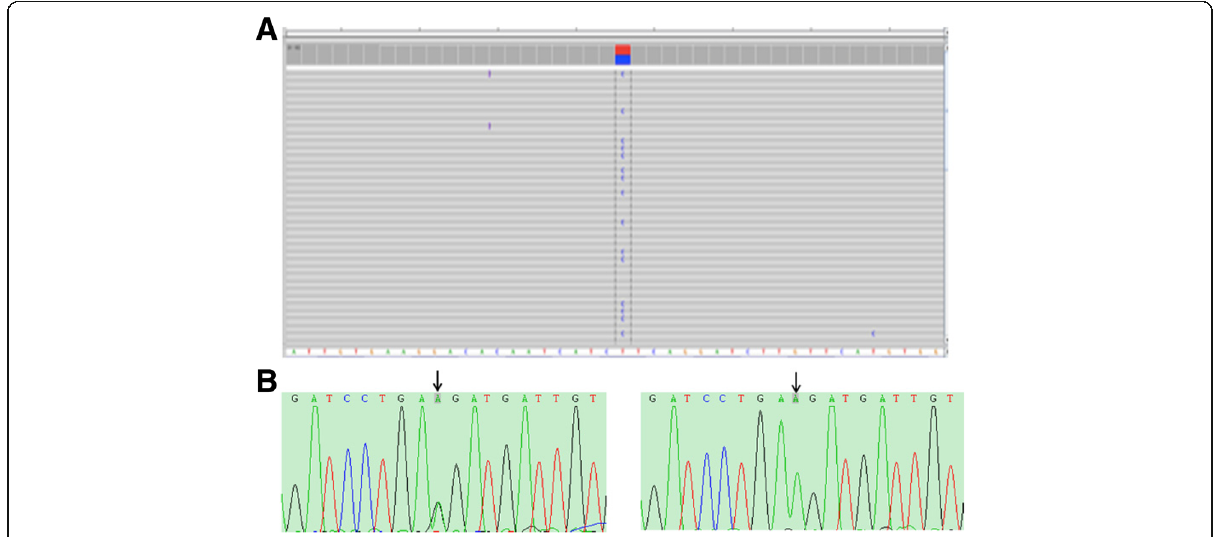
Fig. 3 Genetic characterisation of Caroli ’ s syndrome was performed via PKHD1 mutational analysis. a Results from next-generation sequencing of the patient ’ s genome. A heterozygous mutation (A > G, frequency: 61.45%) was detected in exon 20 (c.1877) of the PKHD1 gene. b Parental mutation analysis in PKHD1 exon 20. The same heterozygous missense mutation (c.1877A > G, p.Lys626Arg) was detected in the father (arrow, left), while the mother carried the wild-type genotype (arrow,